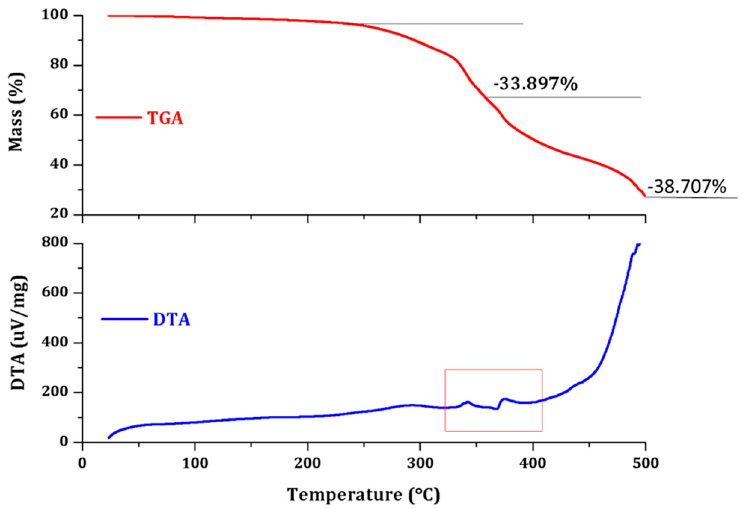
Figure 12. Thermogravimetric analysis (TGA)/differential thermal analysis (DTA) analysis of the PUF-DCPD system.